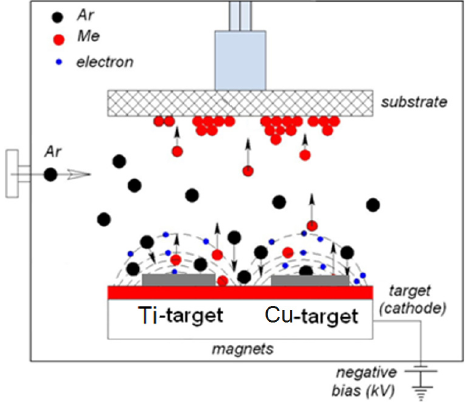
Figure 3. Schematic representation of the two target ‐ sputtering unit used to deposit inactivating agents on the substrates.